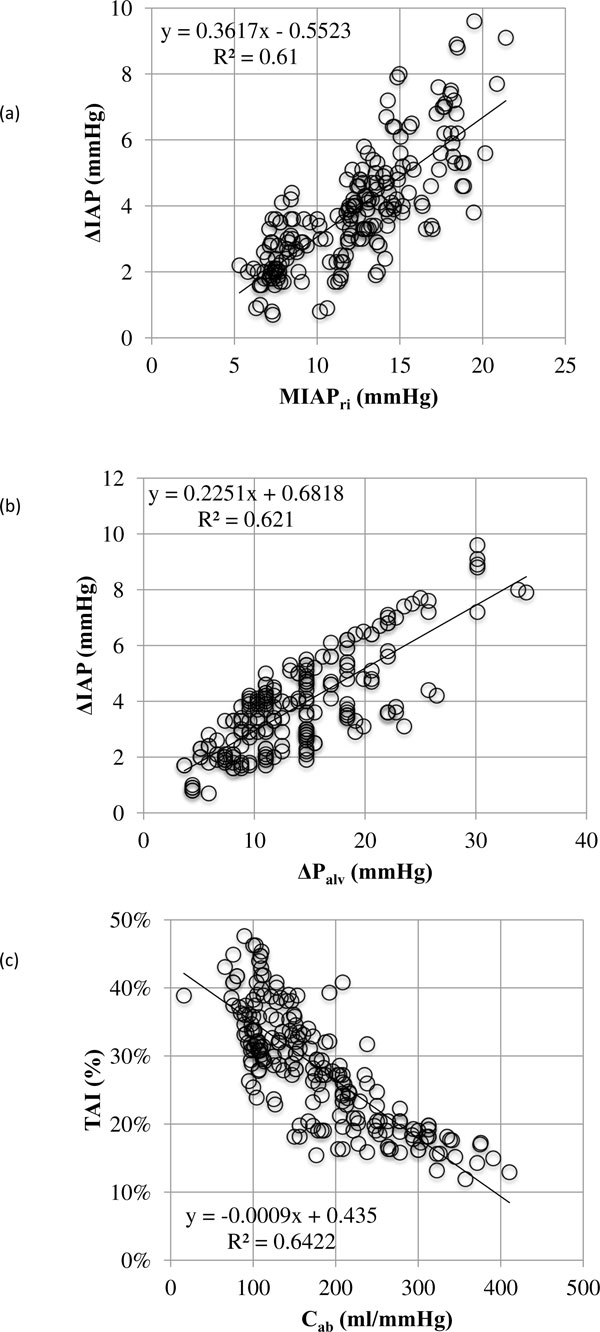
Linear regression plots. (A) Linear regression plot showing the respiratory-integrated mean intra-abdominal pressure (MIAPri) in relation to ΔIAP (= IAPei − IAPee, where IAPei is the end-inspiratory IAP and IAPee is the end-expiratory IAP). (B) Linear regression plot showing the respiratory changes of intra-abdominal pressure (ΔIAP) in relation to ΔPalv (= Pplat - PEEP, where Palv is the alveolar pressure, Pplat is the plateau alveolar pressure, and PEEP is the positive end-expiratory pressure). (C) Linear regression plot showing the relation between the thoraco-abdominal index of transmission (i.e. TAI = ΔPalv /ΔIAP) and the abdominal wall compliance (i.e. Cab = TV/ΔIAP).